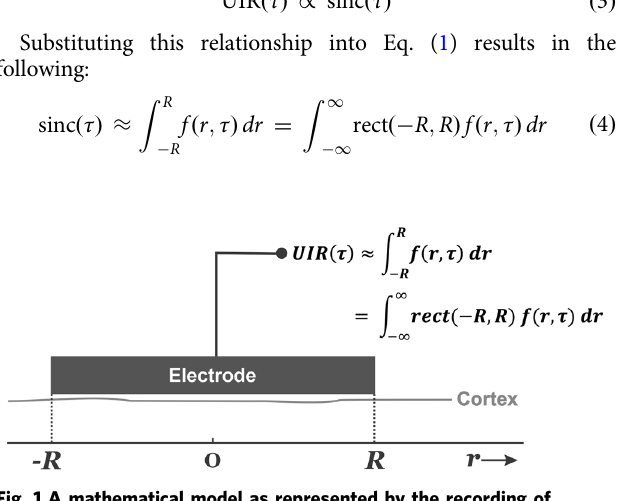
Fig. 1 A mathematical model as represented by the recording of macroelectrode measures the underlying network ’ s unit impulse response (UIR) to a centrally located impulse. The electrode covers an area of one-dimensional cortex where we record the effect related with a single ictal action potential at location r ¼ 0 and time τ ¼ 0, represented by the unit impulse δ ð r ; τ Þ . In this scenario, the macroelectrode measures the underlying network ’ s temporal component of the UIR, UIR ð τ Þ . This measurement can be approximated by an unknown spatiotemporal cortical function, f ð r ; τ Þ associated with the action potential, integrated over